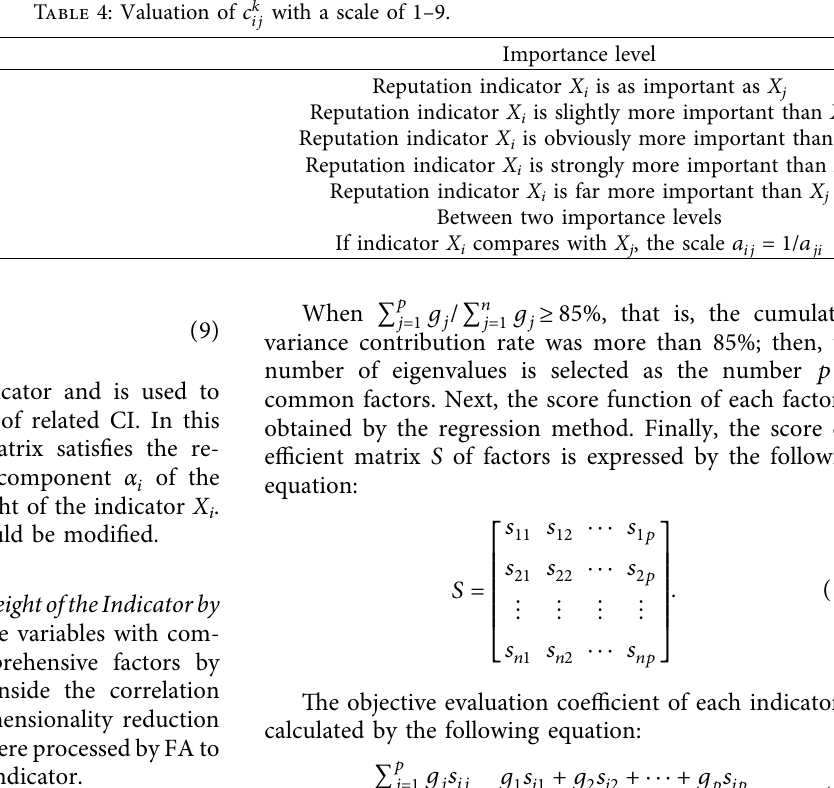
Table 4: Valuation of c k